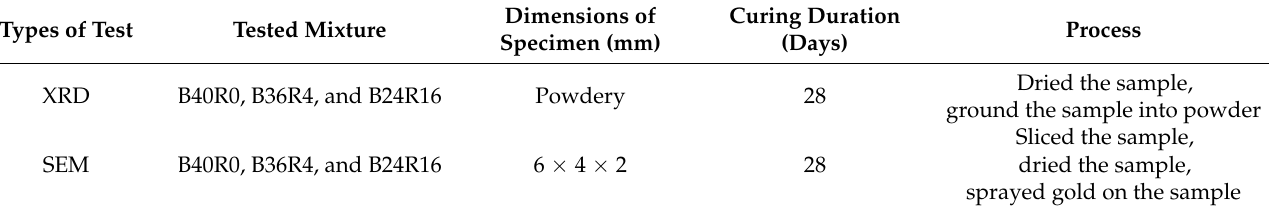
Table 4. Specifications of the testing program for XRD and SEM.